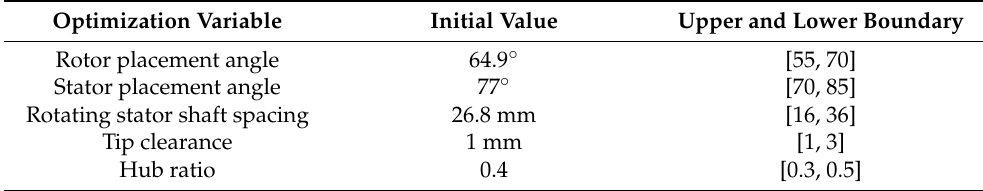
Table 2. Optimization